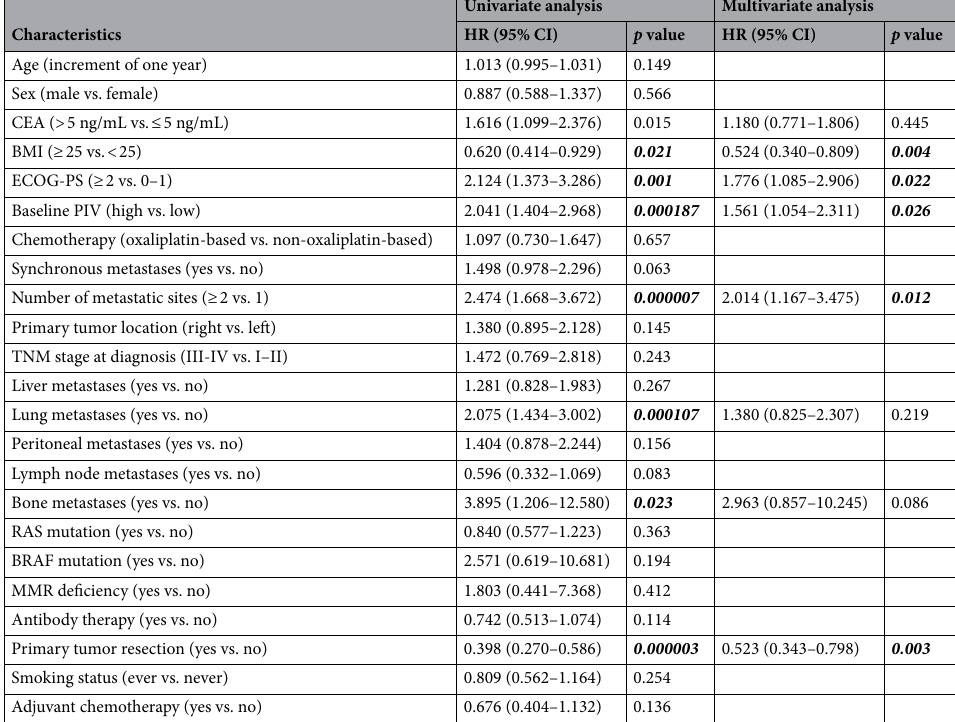
Table 3. Univariate and multivariate Cox regression analyses for progression-free survival. HR hazard ratio, CI confidence interval, CEA carcinoembryonic antigen, BMI body mass index, ECOG‑PS Eastern Cooperative Oncology Group Performance Status, PIV Pan-Immune-Inflammation Value. Bold italics numbers indicate statistically significant